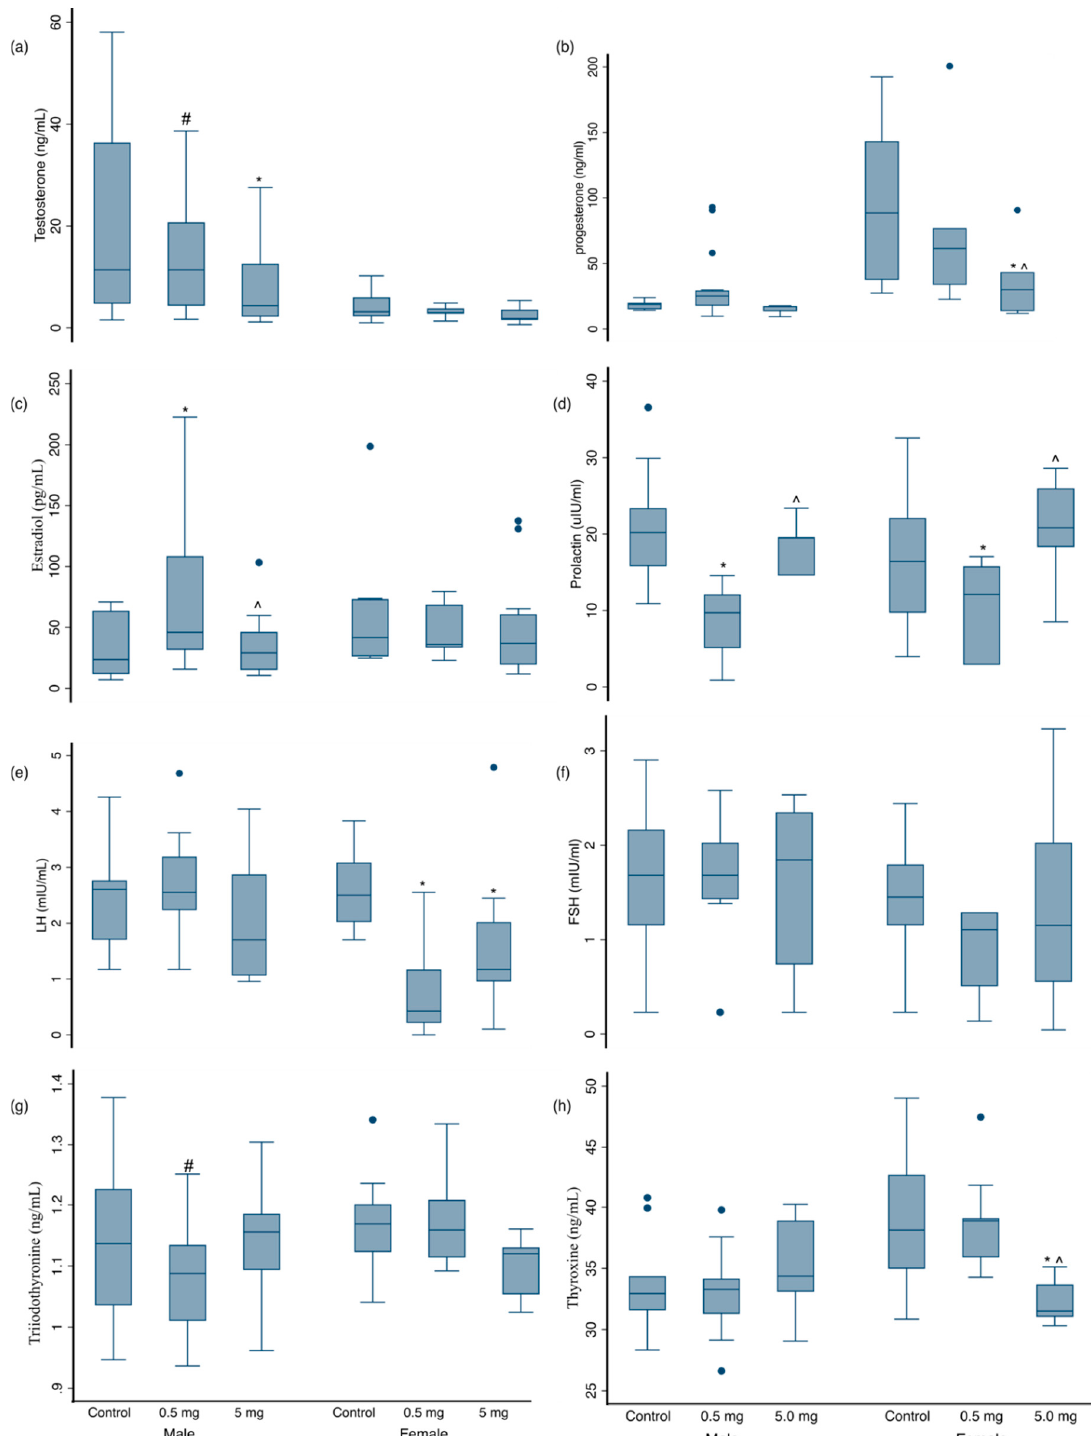
Figure 1. Early Life AFB1 Exposure and Hormones in 3-month Offspring. Distributions of plasma hormones at 3 months of age are shown for male and female offspring of the unexposed (control) and low- and high-exposure groups for the following hormones: ( a ) Testosterone, ( b ) Progesterone, ( c ) Estradiol, ( d ) Prolactin, ( e ) Luteinizing hormone (LH), ( f ) Follicle-stimulating hormone (FSH), ( g ) Triiodothyronine (T3), and ( h ) Thyroxine (T4). Boxes represent the interquartile range (IQR) while the line inside each box represents the median. The whiskers represent 1.5 × IQR while the dots are outliers. * Denotes significantly different from control at p < 0.05, # significantly different from control at p < 0.01, ^significantly different from the low exposure group at p < 0.05.